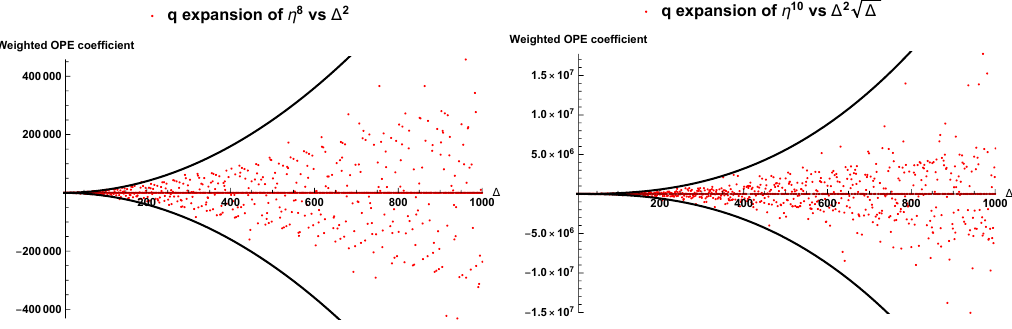
Figure 6 . The q expansion coe(cid:14)cient as a function of (cid:1) is bounded by (cid:1) (cid:1) O = 2 , the black lines are (cid:6) (cid:1) (cid:1) O = 2 .